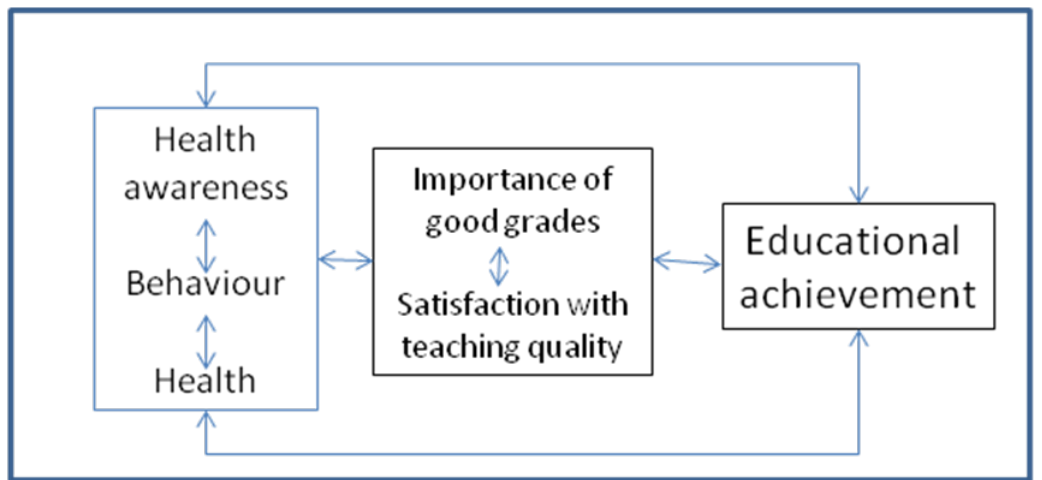
Figure 1. Model of reciprocal relationships between health, health behaviour and educational